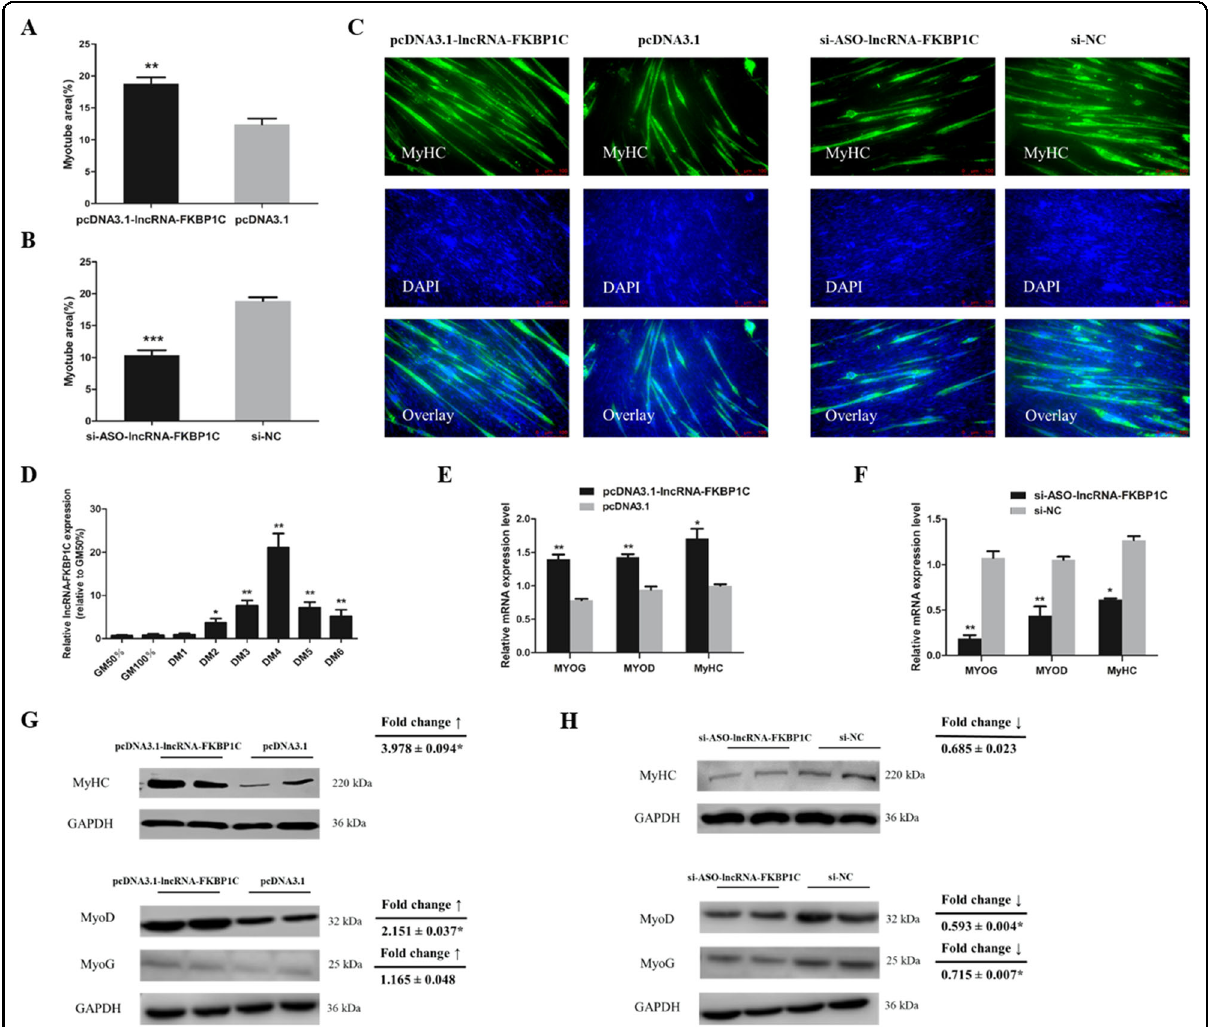
Fig. 3 LncRNA-FKBP1C promotes cell differentiation. A, B Myotube area (%) of CPM cells transfected with pcDNA3.1-lncRNA-FKBP1C, pcDNA3.1, si-ASO-lncRNA-FKBP1C or si-NC. C MyHC Immuno fl uorescence staining of CPM cells. D The relative expression of lncRNA-FKBP1C during CPM differentiation. E, F The relative expression of MyoD, MyoG , and MyHC . G, H The protein expression of MyHC, MyoD, MyoG were determined by Western blotting in CPM cells. Results are shown as mean ± S.E.M. and the data are representative of at least three independent assays. Independent sample t-test was used to analyze the statistical differences between groups (* P < 0.05, ** P < 0.01, *** P <